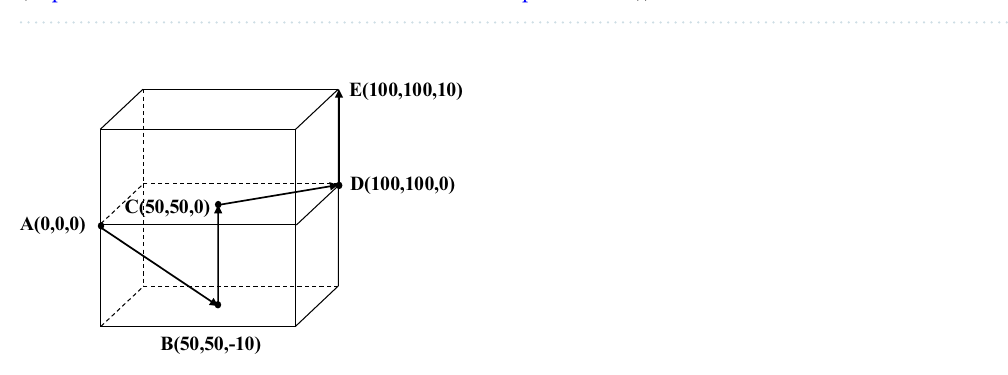
Figure 19. Schematic diagram of the movement of measuring points (The figure was generated by Microsoft Visio Professional 2016 (https:// www. micro soft. com/ zh- CN/ downl oad/ detai ls. aspx? id= 51188)).